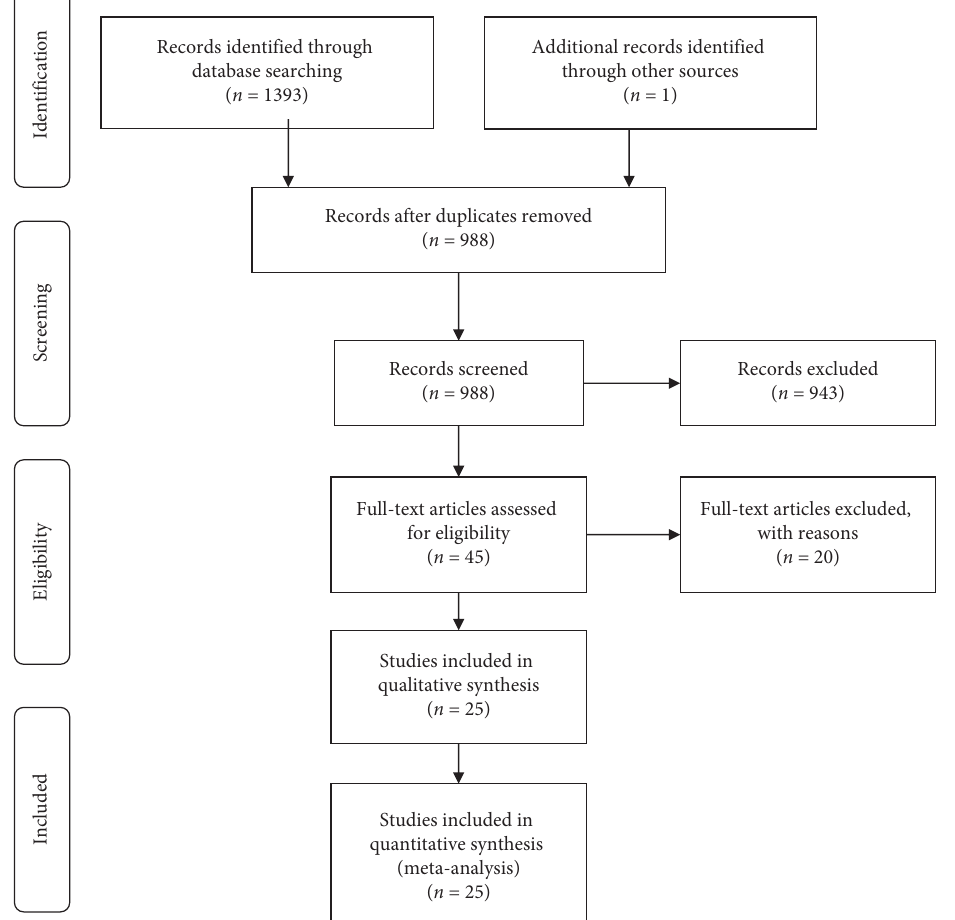
Figure 1: Flow diagram of the study selection